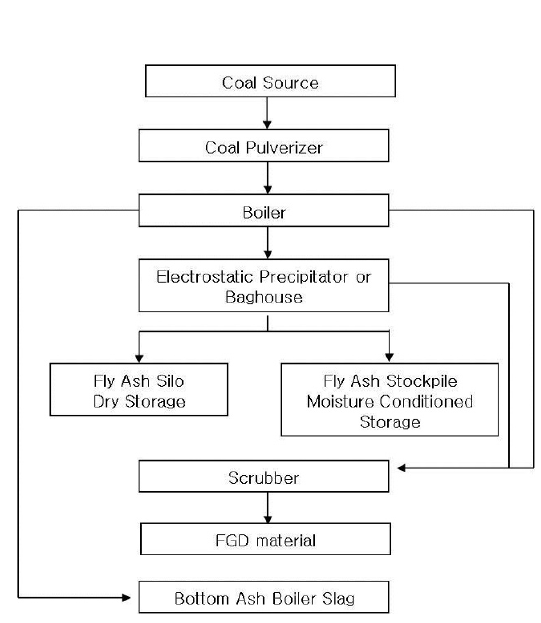
Figure 2. Conventional process for FA and BA